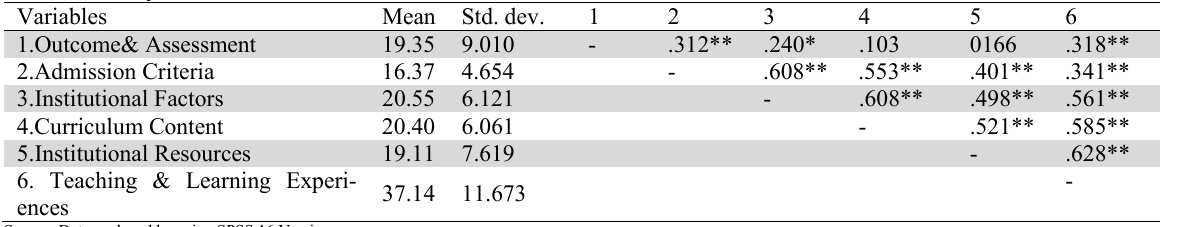
The summary of the statistical observations